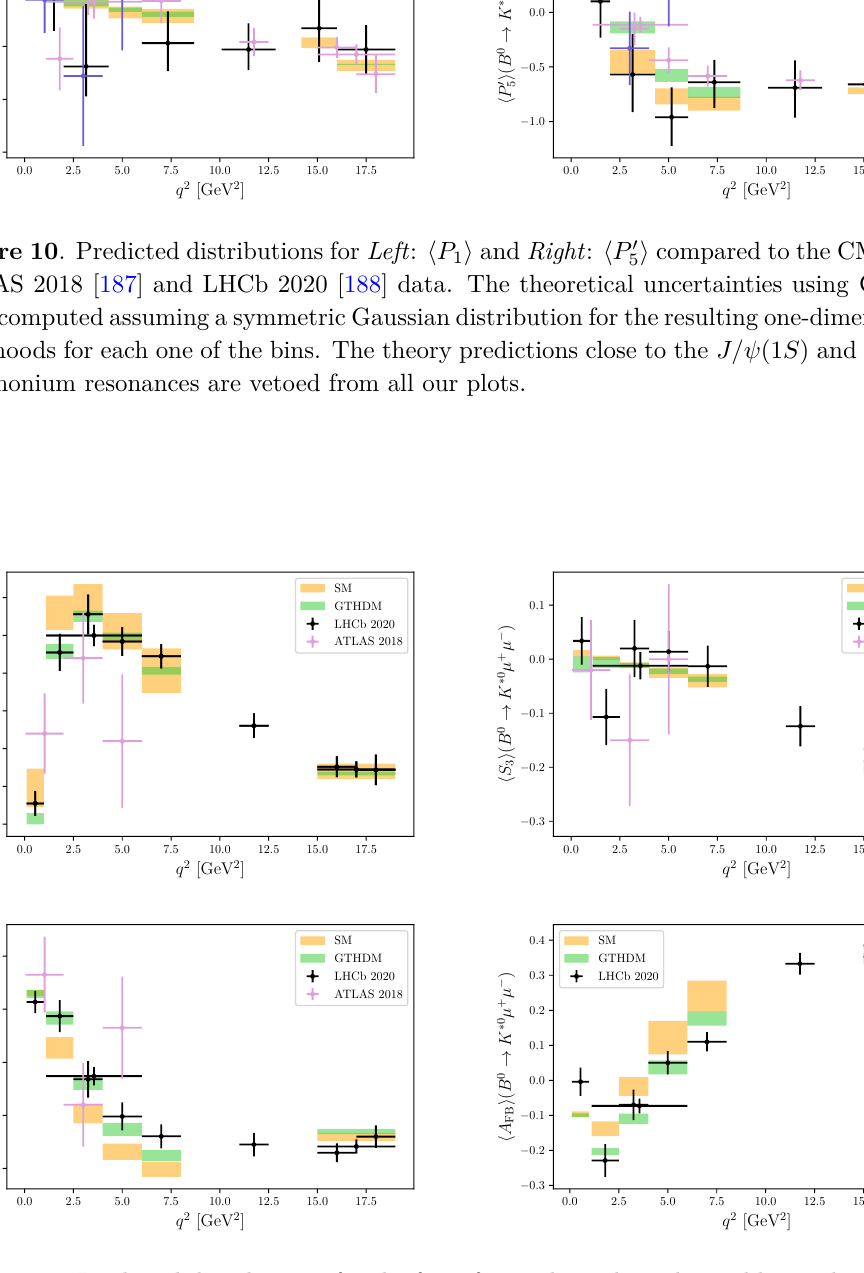
Figure 11 . Predicted distributions for the form factor dependent observables in the S i basis using both the ATLAS 2018 [187] and the LHCb 2020 [188]